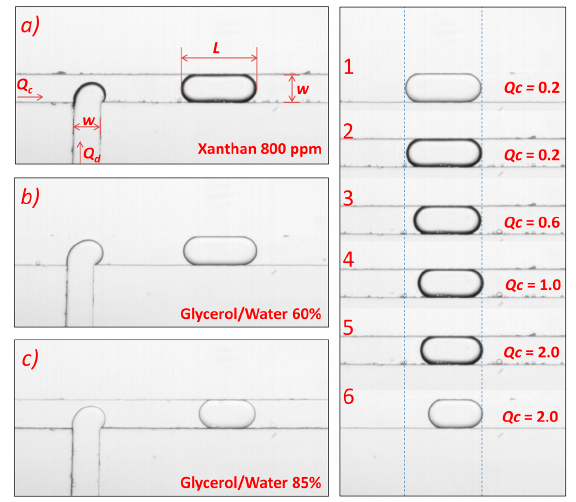
Figure 1. Images ( a )–( c ): snapshots of the production of linseed oil droplets in different continuous phases taken at the same flow rate ratio φ = 0.5 and Q c = 0.6 μ L/min. The width of the microchannels forming the T-junction device is w = 120 μ m and their height h = 90 μ m. Images 1–6: snaphots of linseed droplets in different continuous phases at the same φ = 0.5 and different Q c measured in μ L/min. Images 1 and 6 refer to 60% ( w / w ) glycerol/water and 2–5 to 800ppm ( w / w ) xanthan/water solutions as continuous phase.